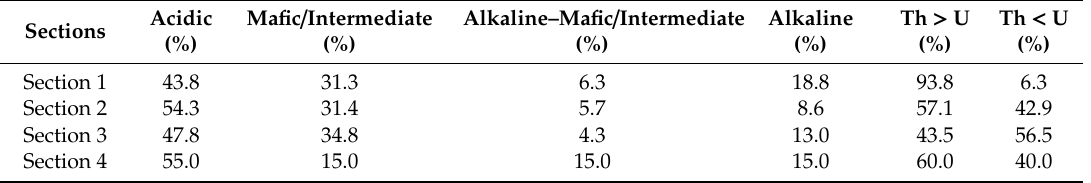
Table 2. Classification of apatites according to La / Nd vs. (La + Ce + Pr) / Σ REE(%) diagram and Th / U